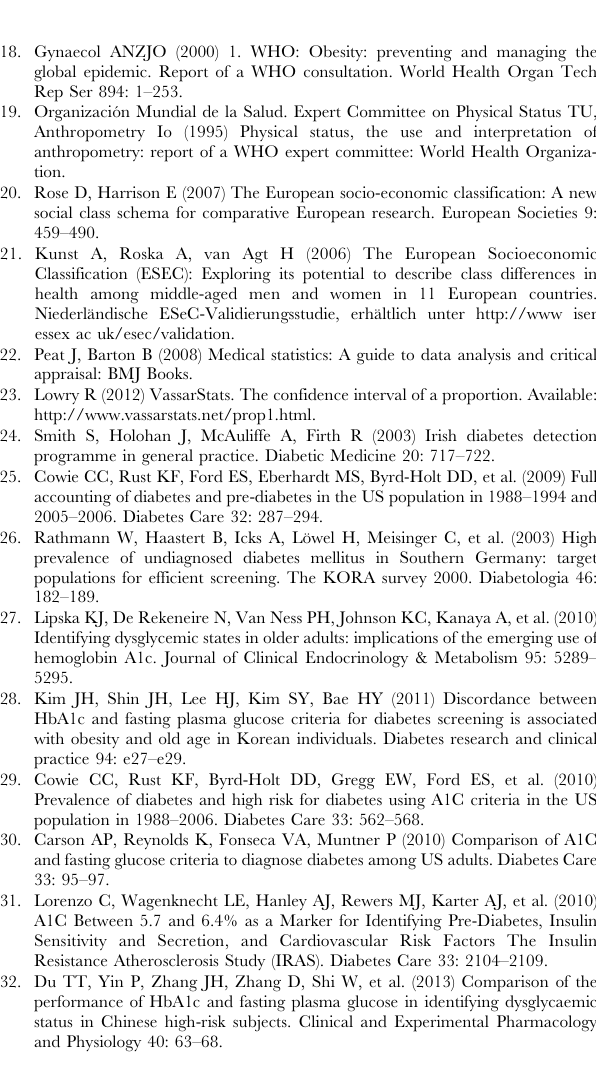
Figure S1 Area under the receiver operating character- istic curves (AUC) for models to discriminate undiag- nosed type 2 diabetes compared to no diabetes. The figure shows area under the curves for models to detect undiagnosed type 2 diabetes. The c statistics values were: (1) c : 0.735, (95% CI: 0.668–0.801) for a model including health insurance and physical activity; (2) c : 0.814, (95% CI: 0.758–0.871) for a model including health insurance, physical activity and BMI (continuous). Figure S2 Area under the receiver operating character- istic curves (AUC) for models to discriminate diagnosed type 2 diabetes compared to no diabetes. The figure shows area under the curves for models to detect diagnosed type 2 diabetes. The c statistics values were: (1) c : 0.608, (95% CI: 0.544– 0.671) for a model including health insurance and physical